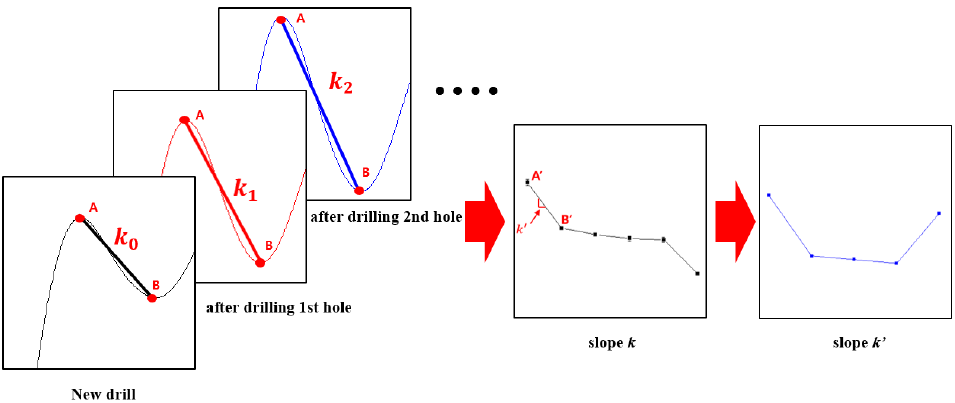
Figure 7. Data processing procedure for drill bit breakage prediction.